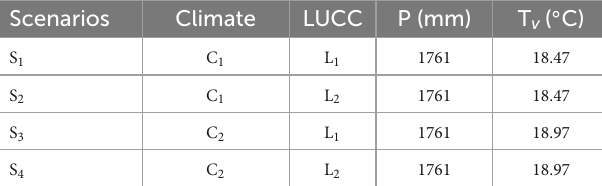
TABLE 4 Different scenarios under SWAT